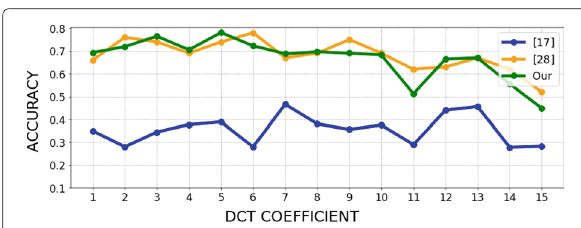
Fig. 4 Average accuracy of the estimation for each DCT coefficient (first is DC) employing standard tables with QF 1 = { 60,65,75,80,85,90,95 } and QF 2 = 90. Plot shows results of our method, Bianchi et al. [17] and Niu et al.